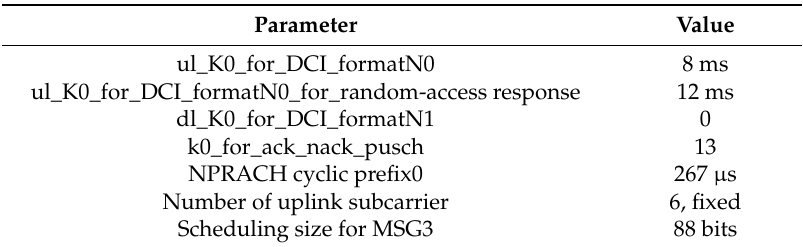
Table 2. Simulation